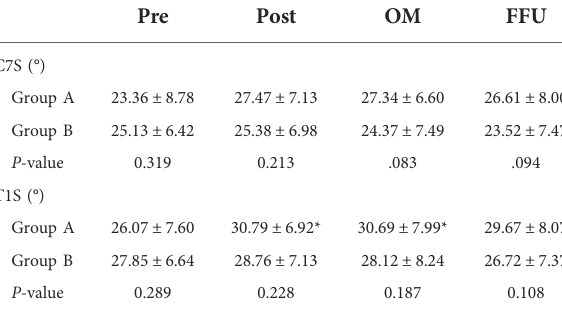
TABLE 4 Comparison of C7S and T1S between the two groups.